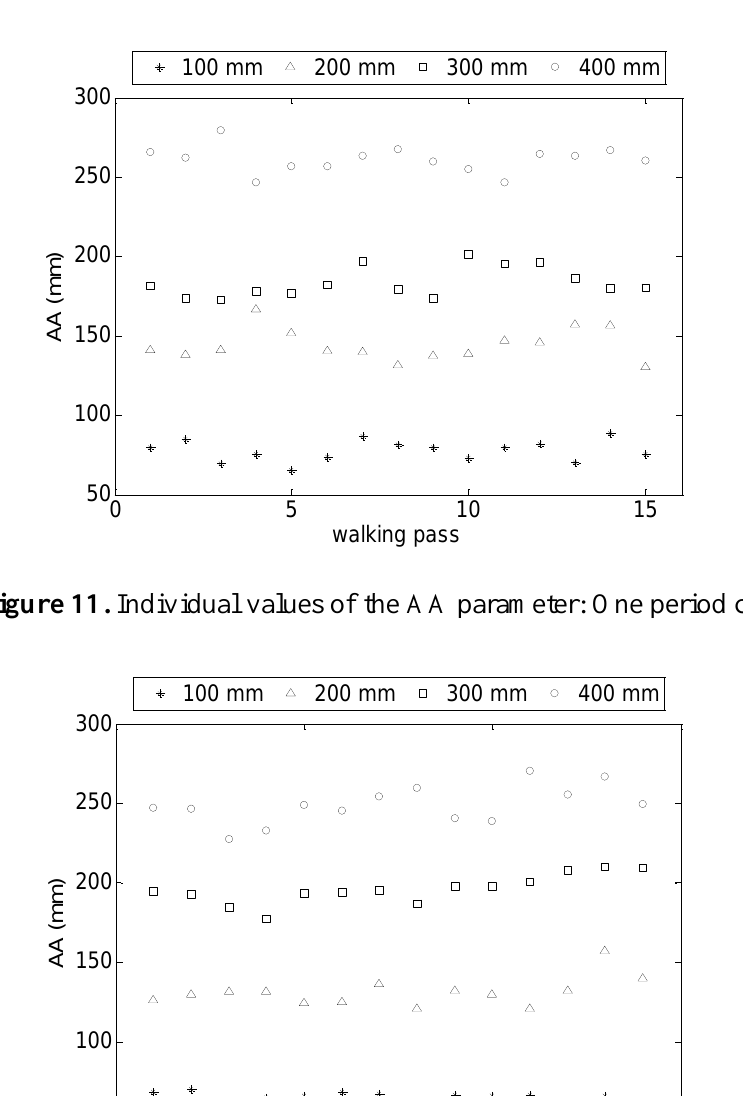
Figure 10. Individual values of the AA parameter: Half period case.